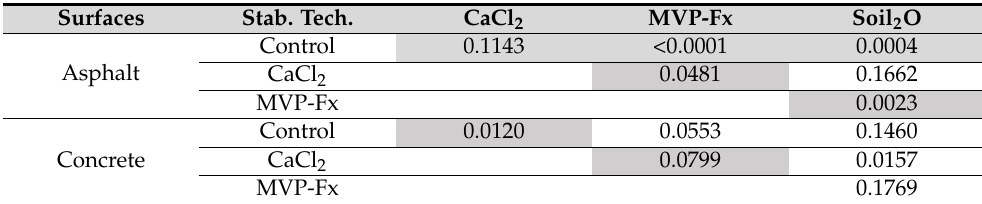
indicates a significant difference ( p < 0.05).